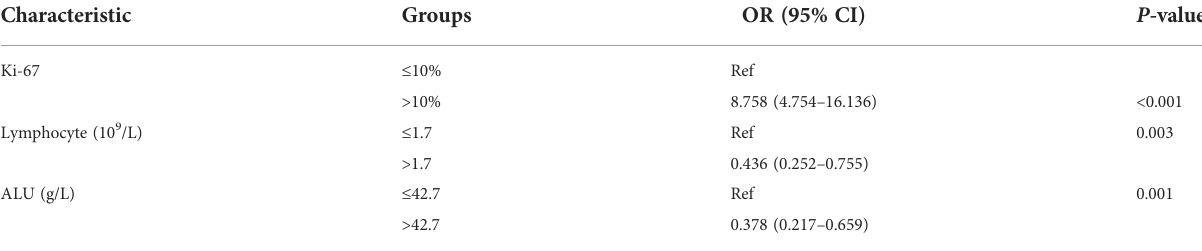
TABLE 3 Multivariate logistic proportional hazards regression analysis in the training cohort. Characteristic